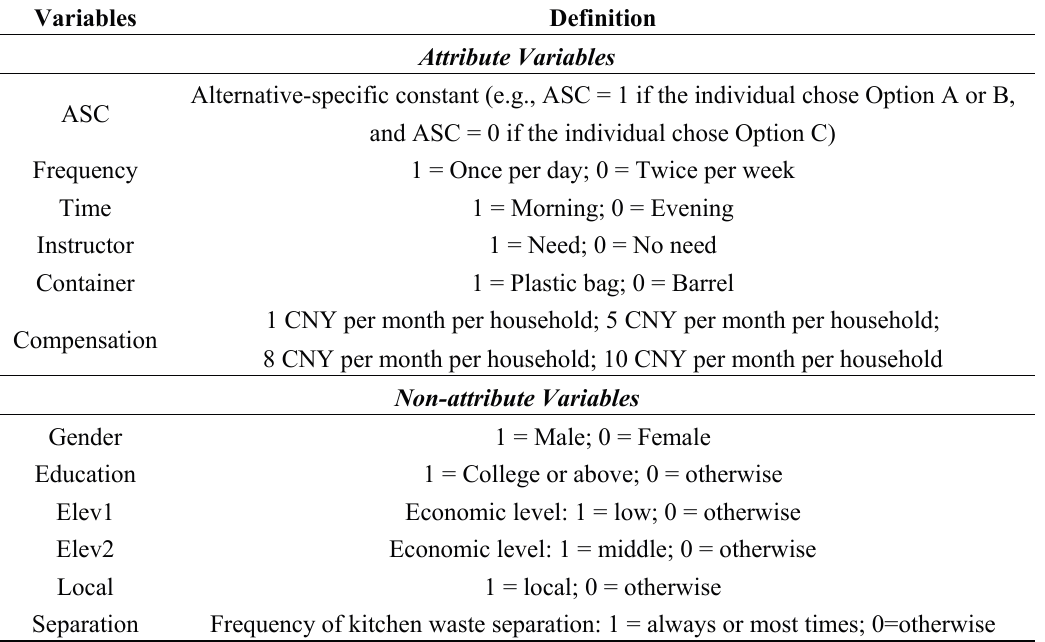
Table 3. Variables included in multinomial logit model analysis and their